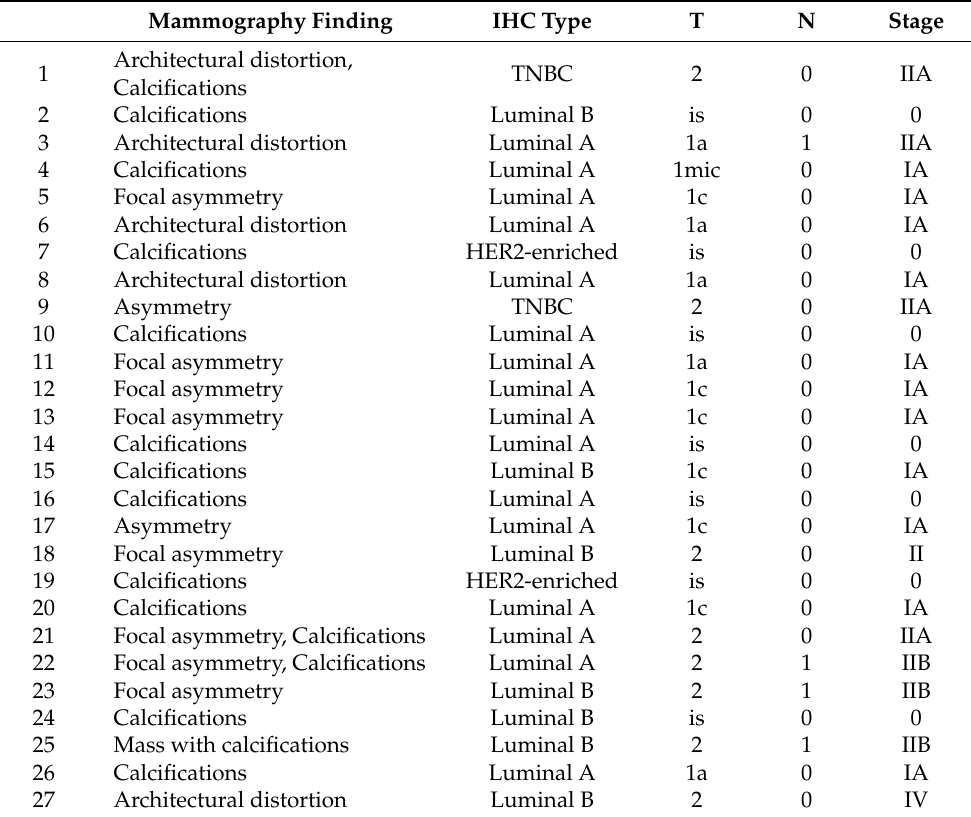
Table 4. Mammography findings of missed cancer in prior